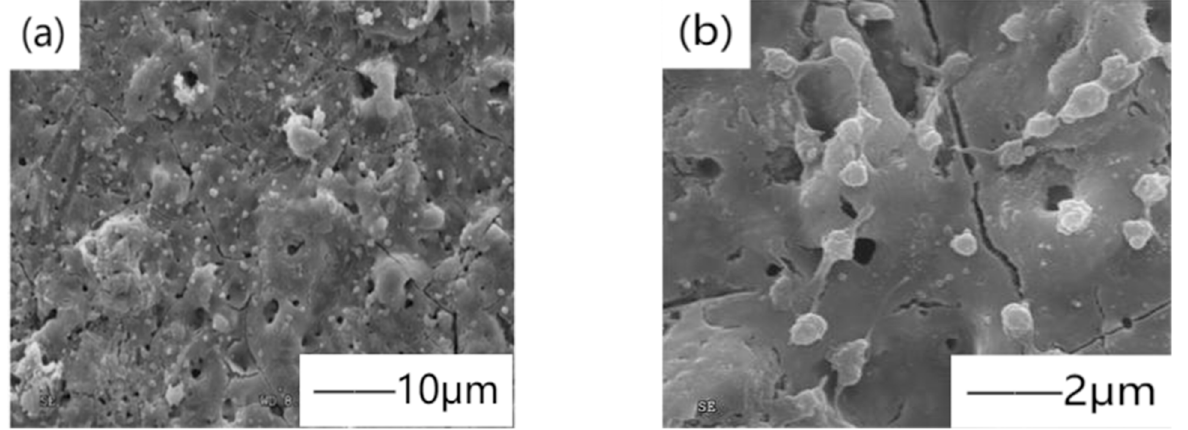
Figure 4. SEM images of blood platelet adhesion on the micro-arc oxidation (MAO) coating HA- containing coating: ( a ) SEM images with scale of 10 µ m, ( b ) SEM images with scale of 2 µ m. Reprinted with permission from Ref. [42]. Copyright 2018 Copyright Elsevier.